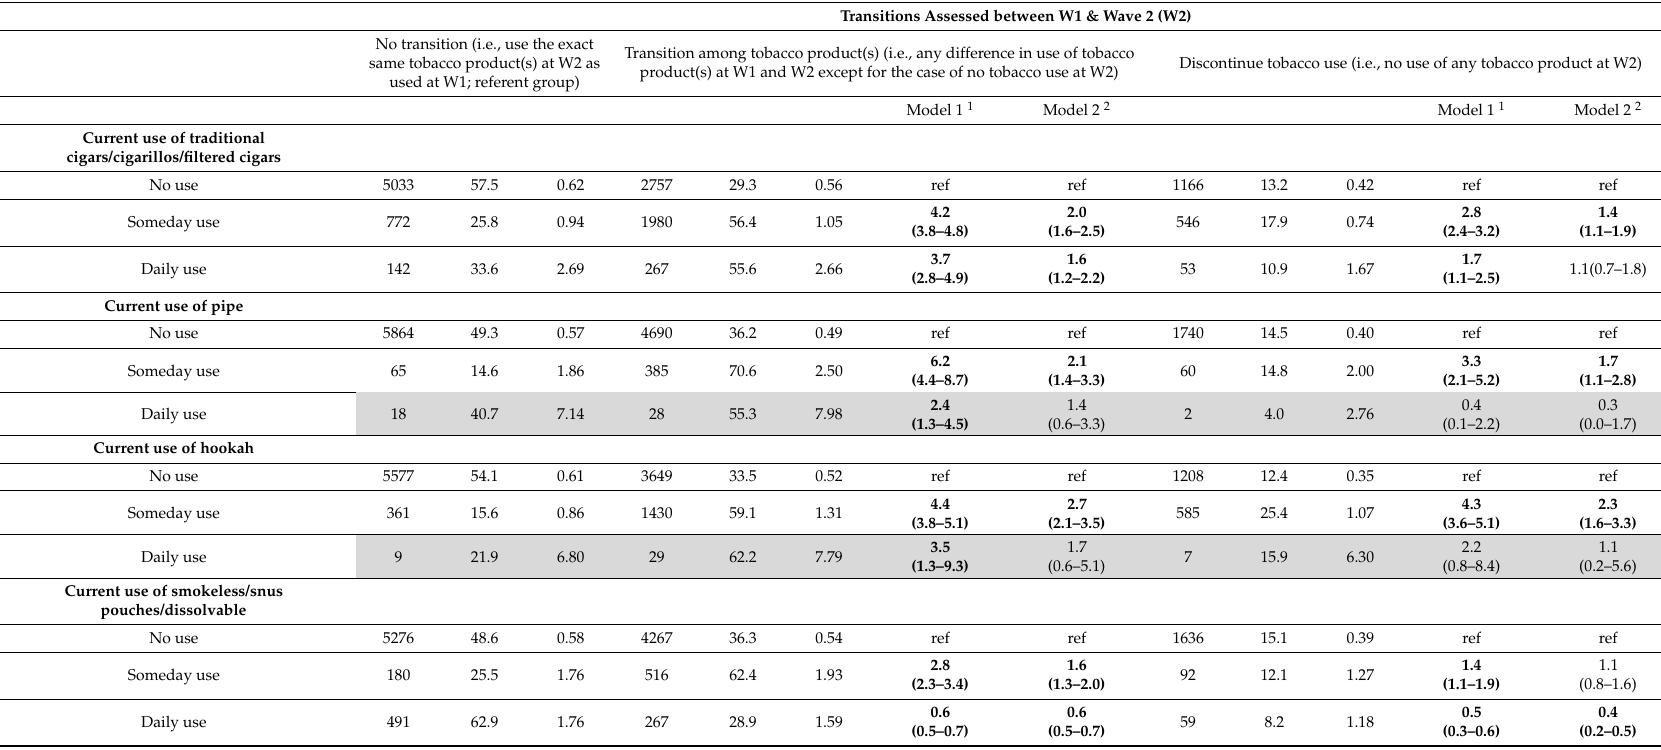
Table 1. Correlates of transitions in tobacco product use among ‘any tobacco’ users at Wave 1 (W1) of the Population Assessment of Tobacco and Health (PATH) Study ⱡ assessed at W1. Current use at each wave defined for cigarettes as having smoked at least 100 cigarettes in lifetime and now smoking everyday or somedays; for hookah as now using everyday, somedays, or monthly; for all other products as now using everyday or somedays. Bold font indicates significant association at α = 0.05; grey shaded cells indicate